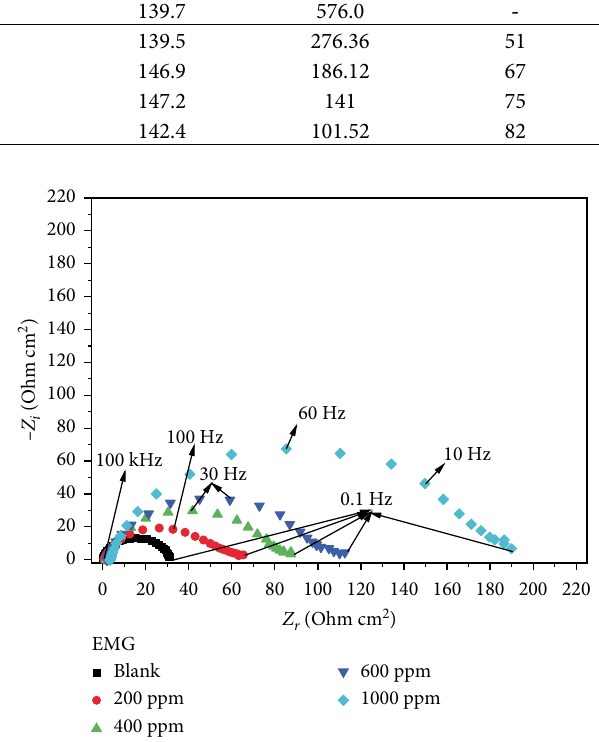
Table 4: Electrochemical parameters and corrosion inhibitory efficacy of steel in 1M HCl without and with addition of EMG at 303 K. Inhibitor